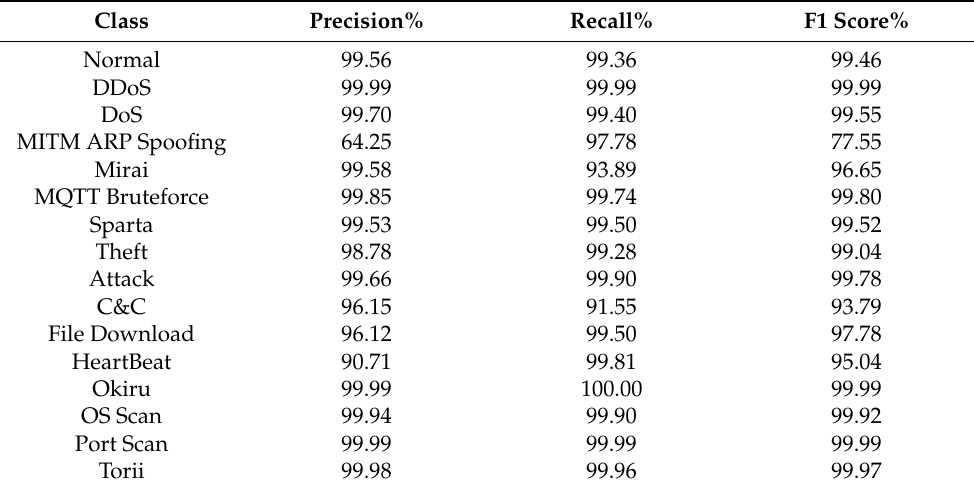
Table 11. IoT-DS-2 multiclass classification (BoT-IoT, IoT network intrusion, MQTT-IoT-IDS2020, and IoT-23